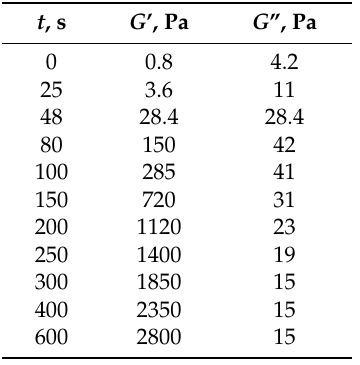
Table 1. Loss and storage moduli (extracted from